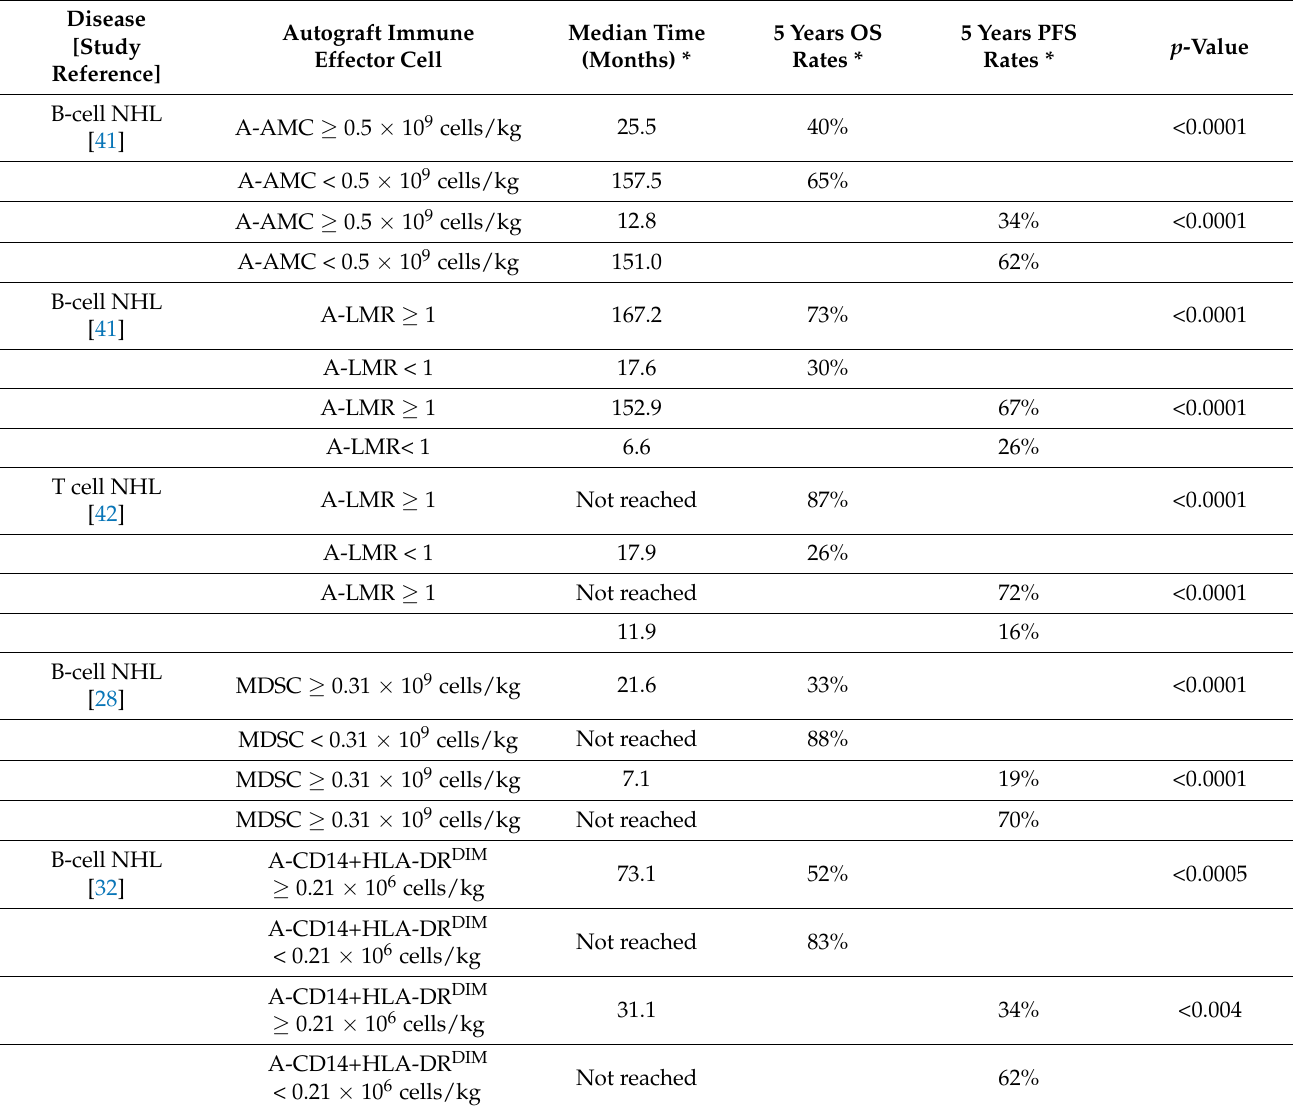
Table 5. Clinical outcomes post-autologous stem cell transplantation based on the infusion of autograft-immunosuppressive effector